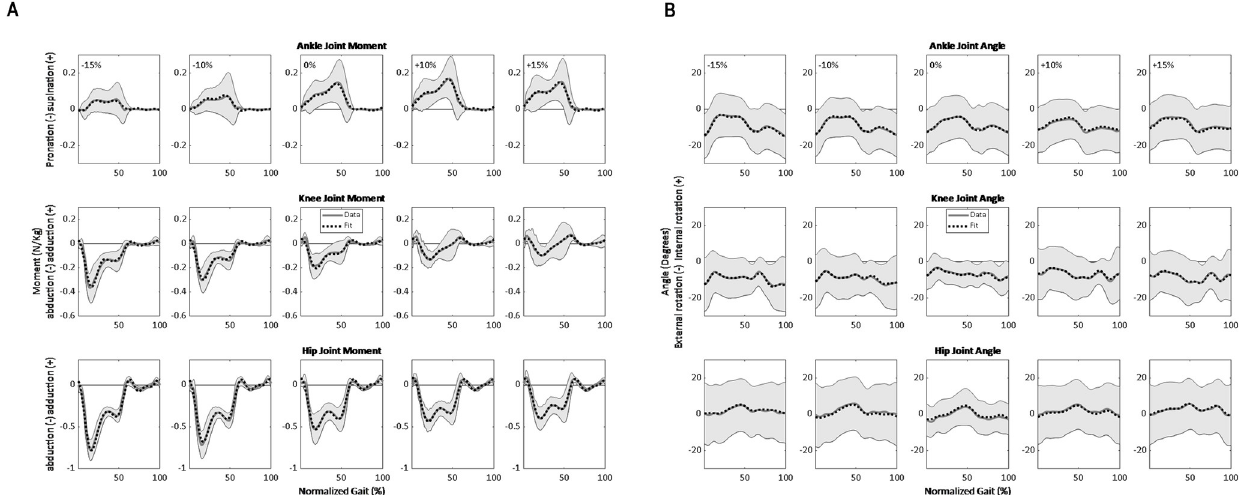
Fig 7. Examples of fit results in the frontal and transverse planes for walking at 1.25 m/s. A: Ankle, knee, and hip moment in the frontal plane (y-axis). B: Ankle, knee, and hip angle in the transverse plane (z-axis). The gray area represents ± 1 standard deviation.